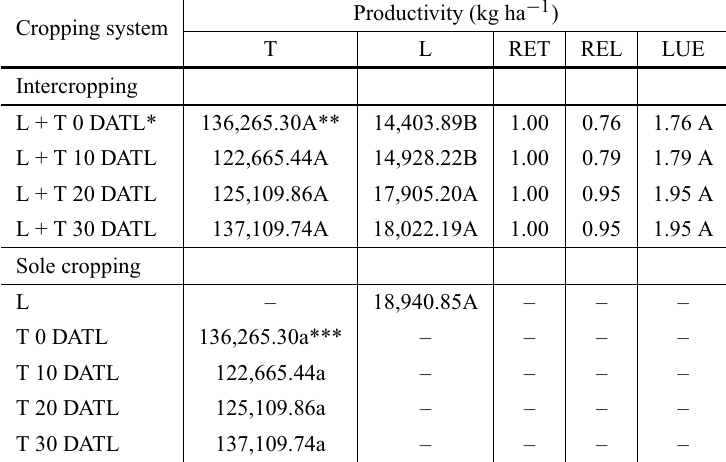
*DATL = days after the transplanting of lettuce. **Means, in each column, followed by the same capital letter, are not significantly different at the 5% level of probability, according to the Tukey’s test; ***Means, in each column, followed by the same small case letter, are not significantly different at the 5% level of probability, according to the Tukey’s